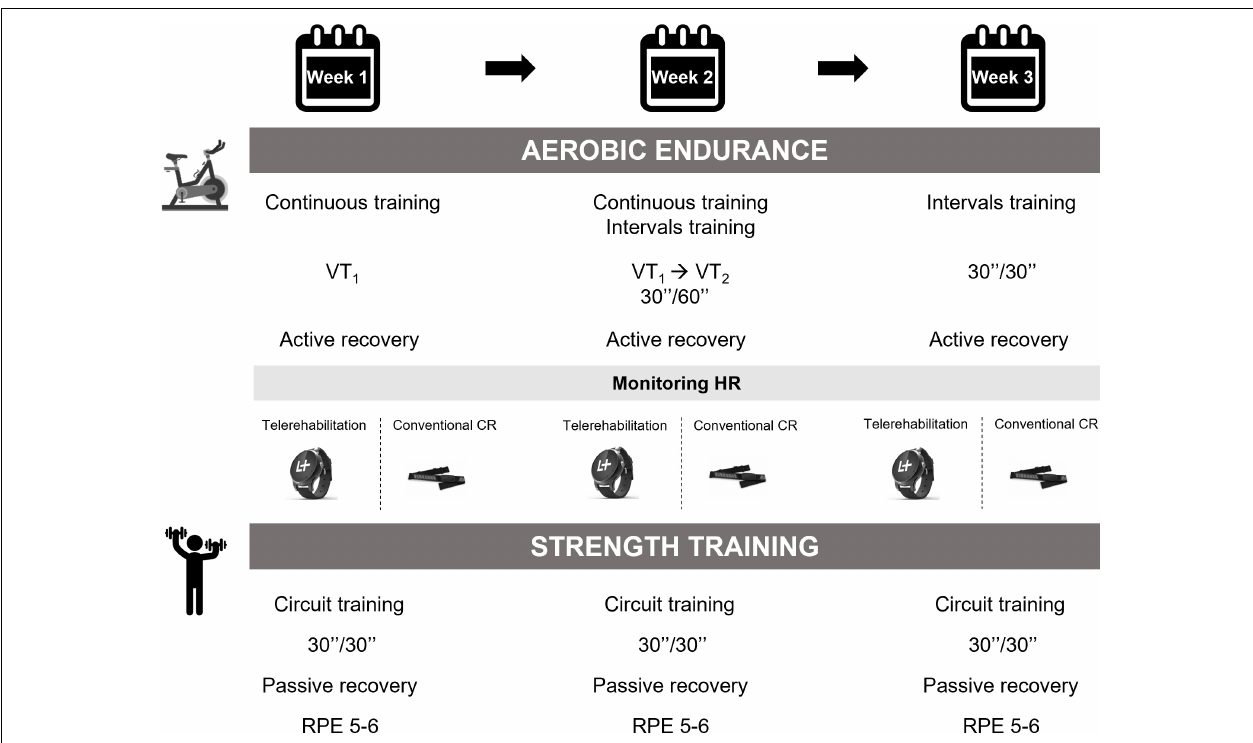
Frontiers in Physiology |